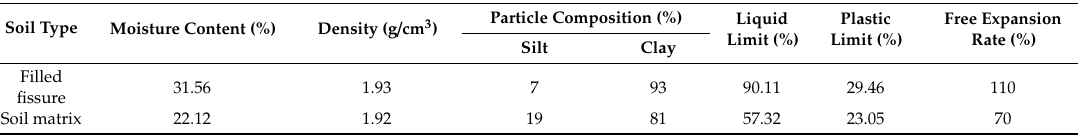
Table 2. Basic physical properties of the soils in the sample.